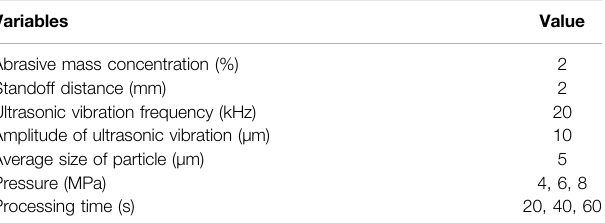
TABLE 2 | Experimental process parameters and